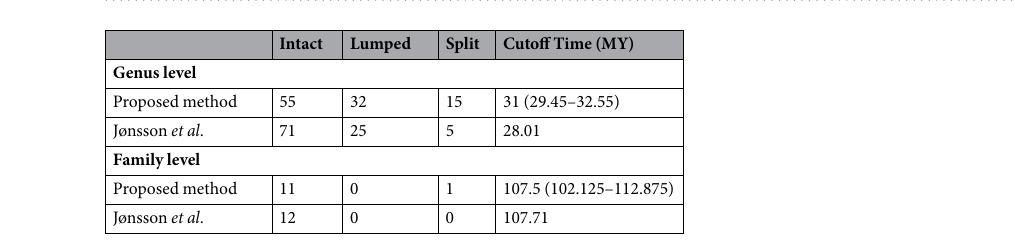
Figure 4. Results of simulations to evaluate sensitivity of temporal banding to taxon sampling. Temporal cut- off indicated as dots (with standard deviation) in relation to amount of removal of taxa from the data set. (A) Temporal cut-off at the genus level. (B) Temporal cut-off at the family level.